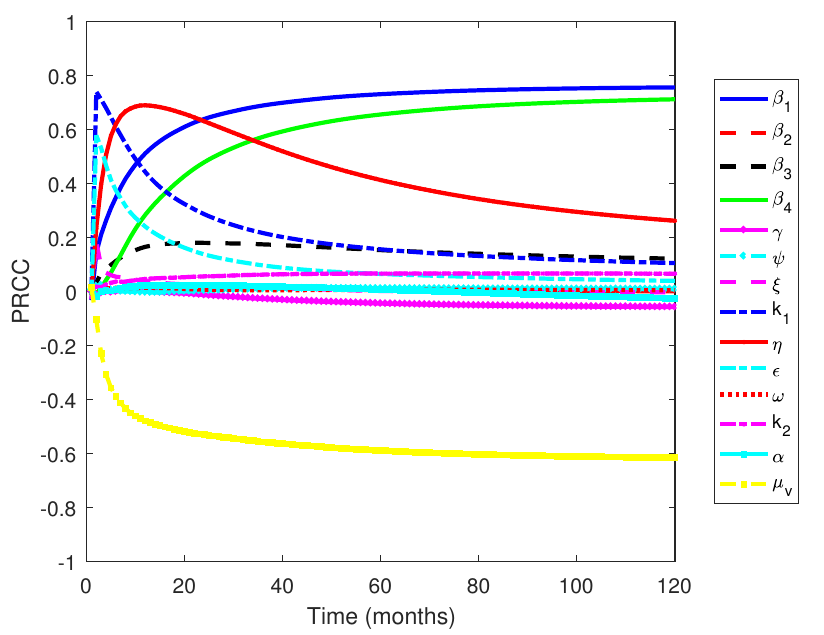
Figure 11. PRCC values when measured against an increasing number of infected individuals over